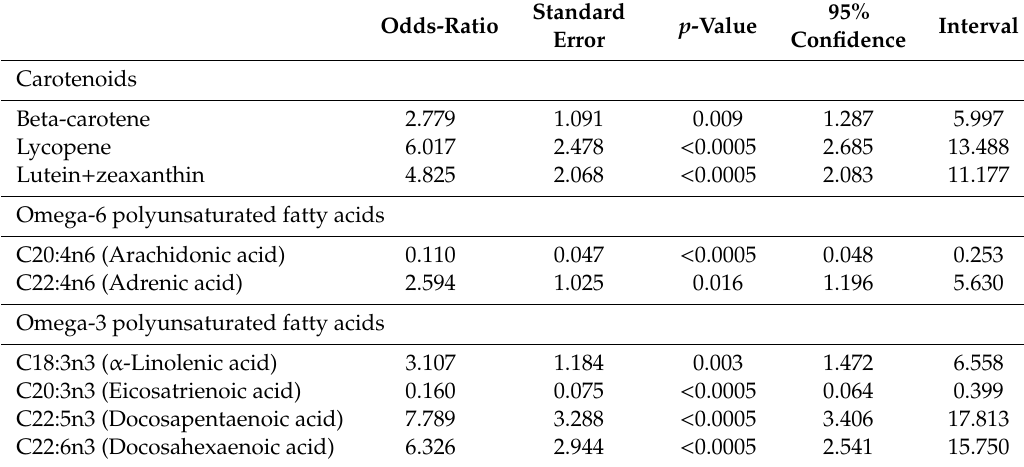
Table 3. Odds ratio of being a case (AMD) in the lowest quartile, using the highest quartile as reference. Only those with a statistically significant results are shown.